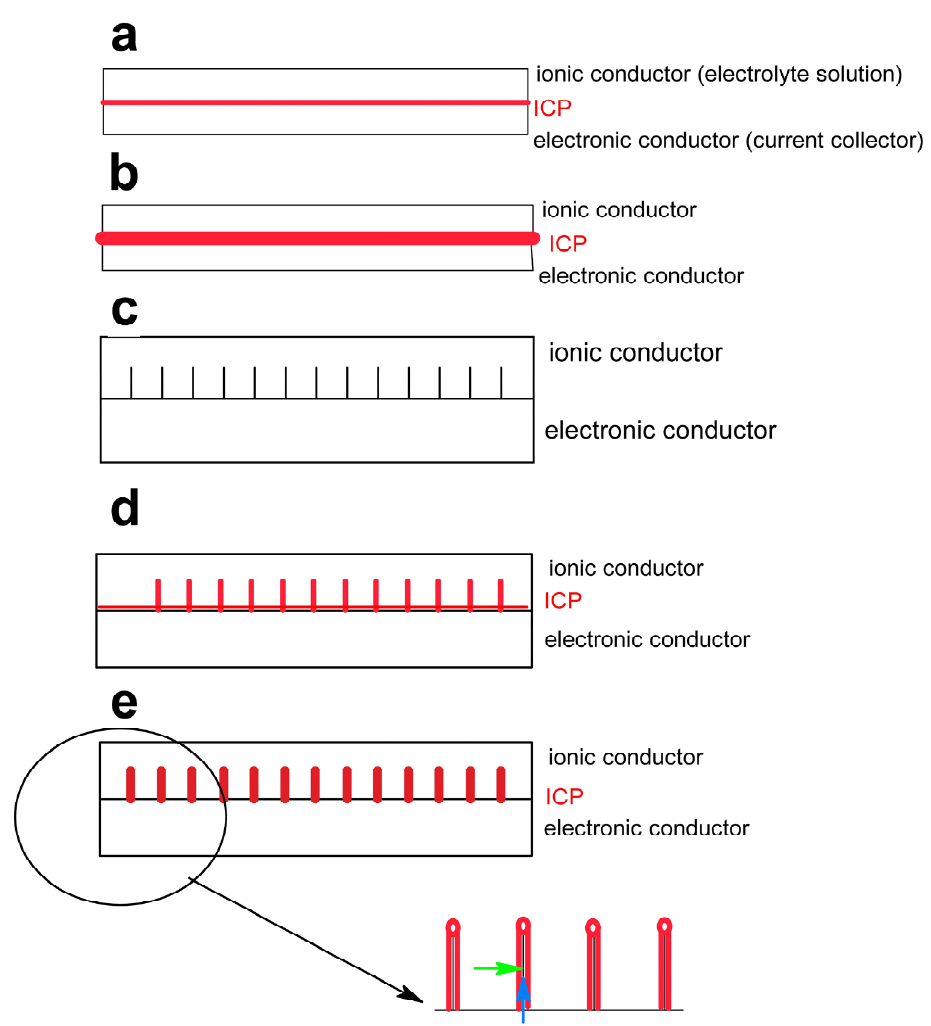
Figure 1. Schematic supercapacitor electrode architectures (bottom right: black: electronically conducting support; red: active mass with ion ( → ) and electron ( → ) pathways, further explanations see text).